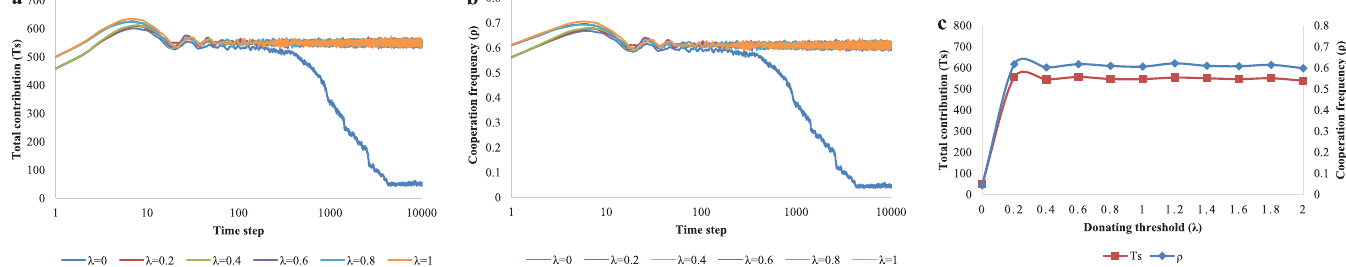
Fig 6. The evolution results of total contributions Ts and cooperation frequency ρ for different values of the donation threshold λ . (a) The evolution process of total contributions for different values of donation threshold ( λ = 0,0.2,0.4,0.6,0.8,1). (b)The evolution results of cooperation frequency for different values of donation threshold ( λ = 0,0.2,0.4,0.6,0.8,1). (c) The equilibrium results of total contributions and cooperation frequency for different values of donation threshold λ varying from 0 to 2 with an interval of 0.2.